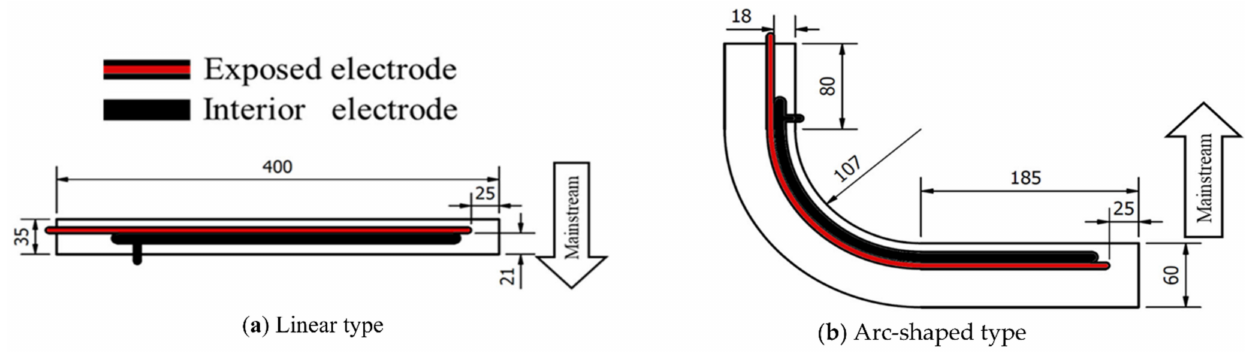
Figure 8. High-durability designed plasma electrodes.